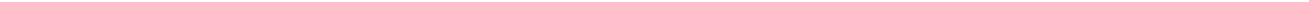
Fig. 3 V γ 9 − V δ 2 + T cells are clonally and phenotypically distinct from V γ 9 + V δ 2 + T cells. a Frequency of V γ 9 chain usage in V δ 2 + TCR repertoire sequencing data from adult peripheral blood ( n = 7). b Identi fi cation of V δ 2 + T cells in CD3 + T cells (left) and V γ 9 − cells within V δ 2 + T cells (right) from cord blood ( n = 5). c Frequency of V γ 9 − and V γ 9 + cells in V δ 2 + T cells from cord blood (left; n = 5) and adult peripheral blood (right; n = 18). d Frequency of V γ 9 − V δ 2 + T cells ( n = 18) and NKT cells ( α Galcer/CD1d + ; n = 5) in adult peripheral blood. e V γ 9 − V δ 2 + T cells identi fi ed by TCR V δ 2 antibody